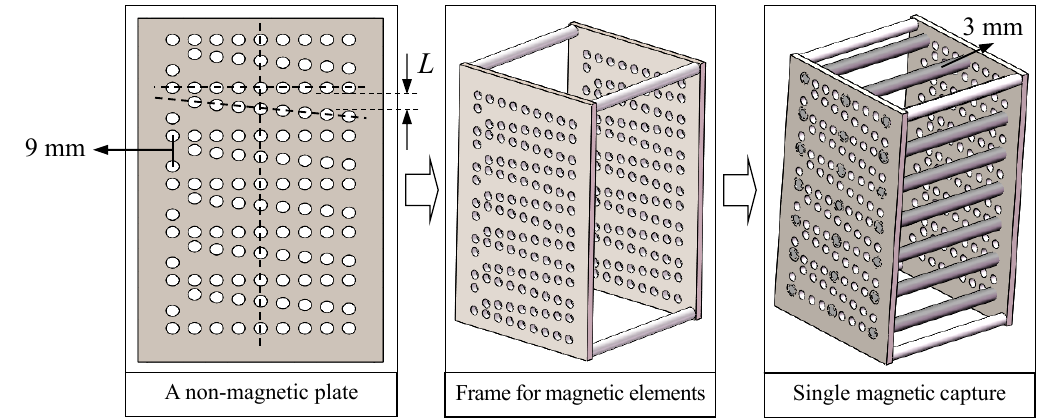
Figure 5. Schematic diagram on operational principle of Magnetic Capture Analysis (MCA) method.